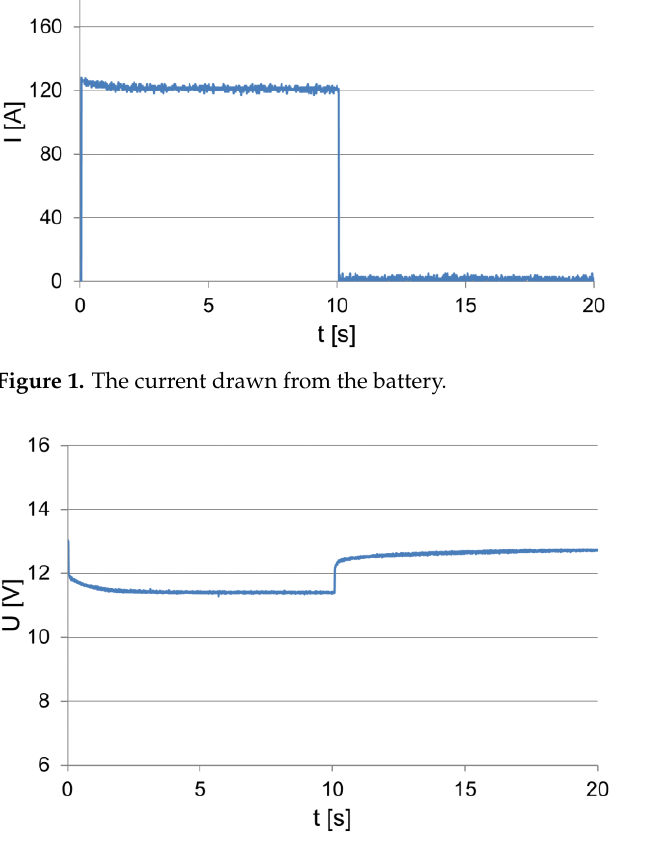
Figure 2. The voltage (to 10 s) at the loaded and unloaded battery terminals.